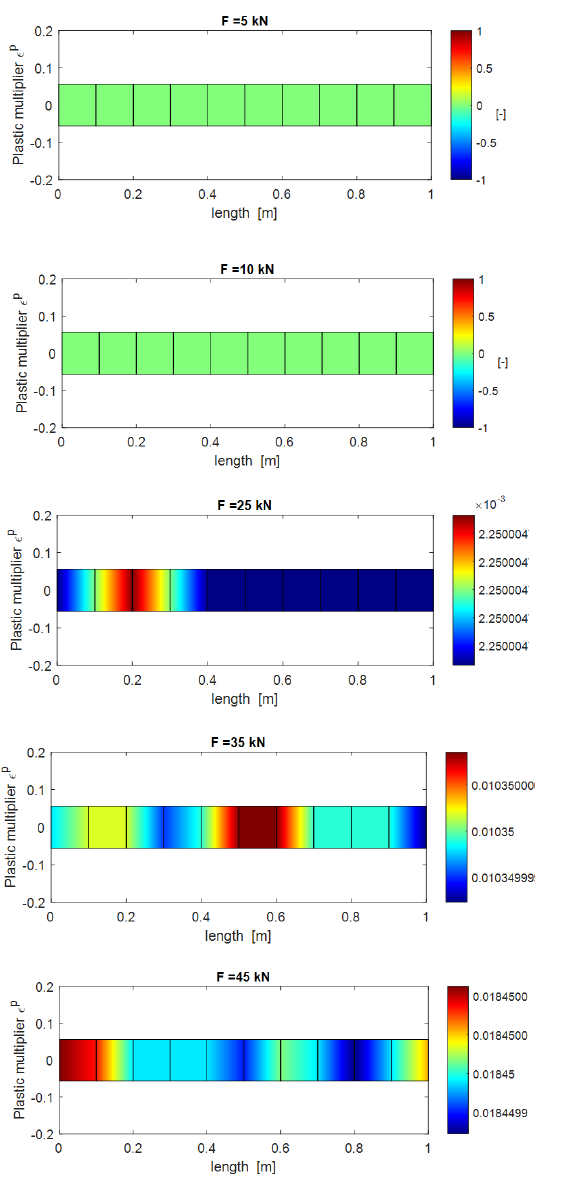
Figure 7. Evolution of the plasticization in the bar with to the applied load.